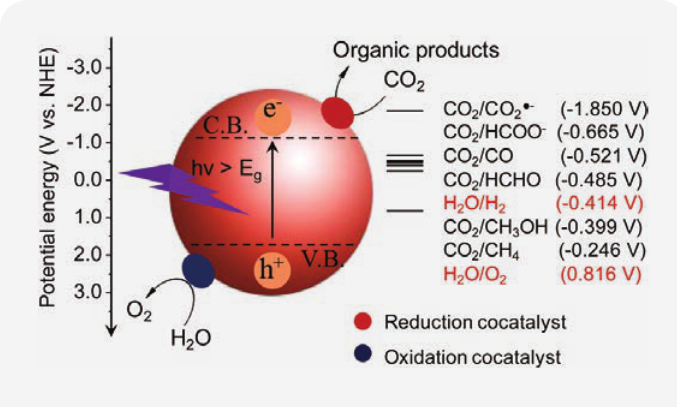
Figure 12. Schematic representation of process of photocatalytic reduction of CO 2 . Reproduced with permission from Ref.